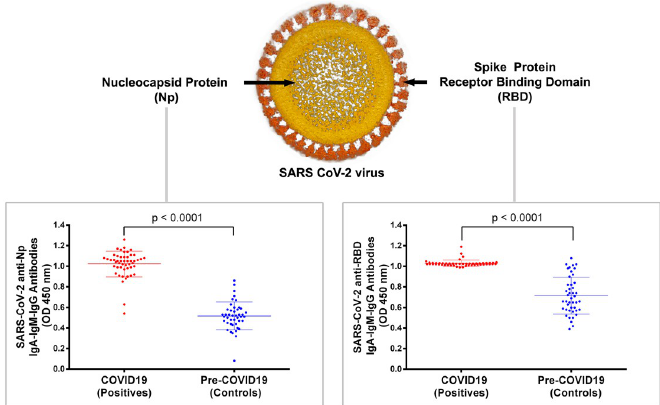
Fig 1. Combined immunodetection of SARS-CoV-2-specific IgA/IgM/IgG immunoglobulins in response against the Nucleocapsid (Np) and receptor-binding domine of spike protein (RBD). Oil painting picture schematic of SARS-CoV-2 viral structure (top panel), N-protein (Np) and RBD from S-protein are showed in light orange and red, respectively. Absorbance at 450 nm plotted for combined detection of IgA, IgM, and IgG specific immunoglobulin isotypes for Np and RBD ELISAs (lower left and lower right panel, respectively). Forty-four sera from pre-pandemic individuals and fifty sera from COVID-19 patients were tested. To compare both groups, a Mann-Whitney U-test was used. Mean+/-SD and P values are showed (P <